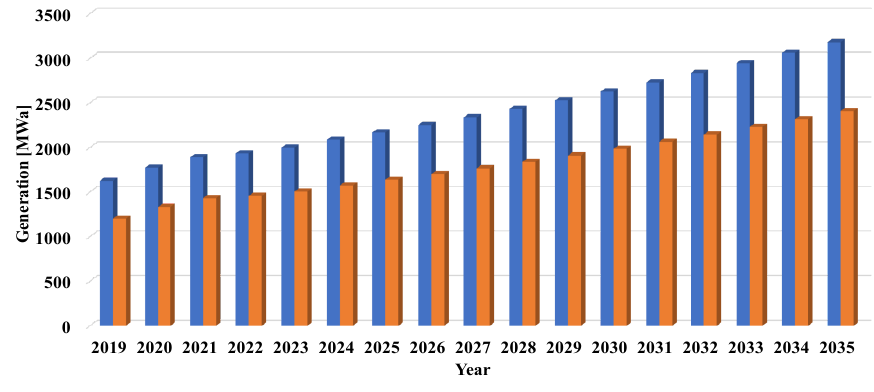
Figure 13. Zambia’s forecasted demand versus actual supply.